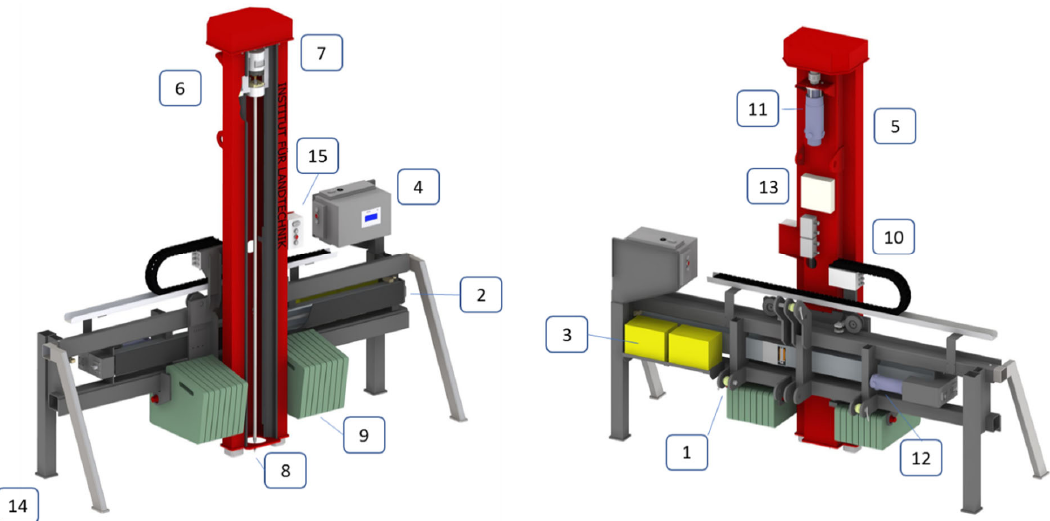
Figure 3. Schematic illustration of the DSP in front and rear views. 1. Tractor 3 point linkage, 2. transversal adjustment (2 m) with ball screw drive, 3. power supply, 4. control box, 5. tower with guide rails for penetrometer, 2 m down-stroke, 6. penetrometer rod with ball screw and slide, 7. load cell for tubes, 8. penetrometer tip, 9. counter balances (16 × 40 kg), 10. amplifier, 11. electrical drive for penetrometer rod, 12. electrical drive for tower movement, 13. drive controller, 14. supply pillar, 15. control panel.